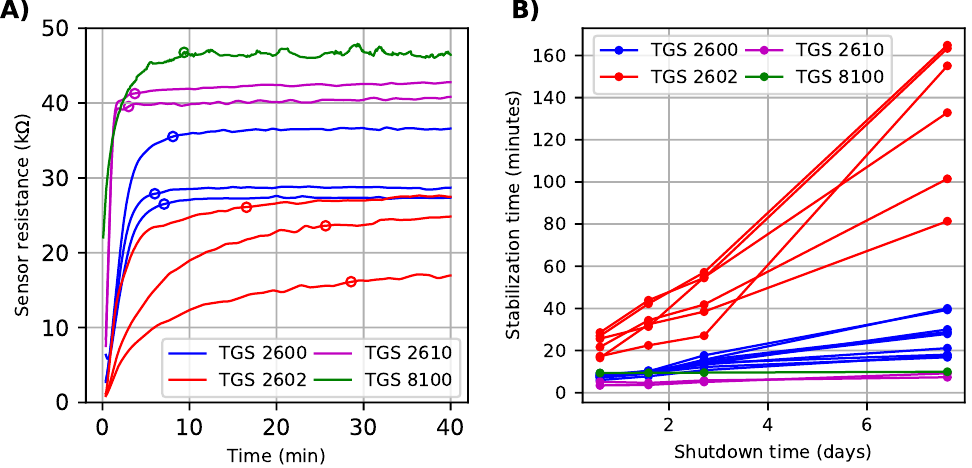
Figure 2. Run-in phase of several isothermally operated MOX sensors (TGS models, Figaro Engineering Inc., Arlington Heights, IL, USA). ( A ) Initial action of the sensor response after a 12-h shutdown. The open circles on top of each trace indicate the stabilization time, defined as the time when the response reaches 95% of its final value. ( B ) Stabilization time as a function of the shutdown period. The sensors were continuously powered for several days before each